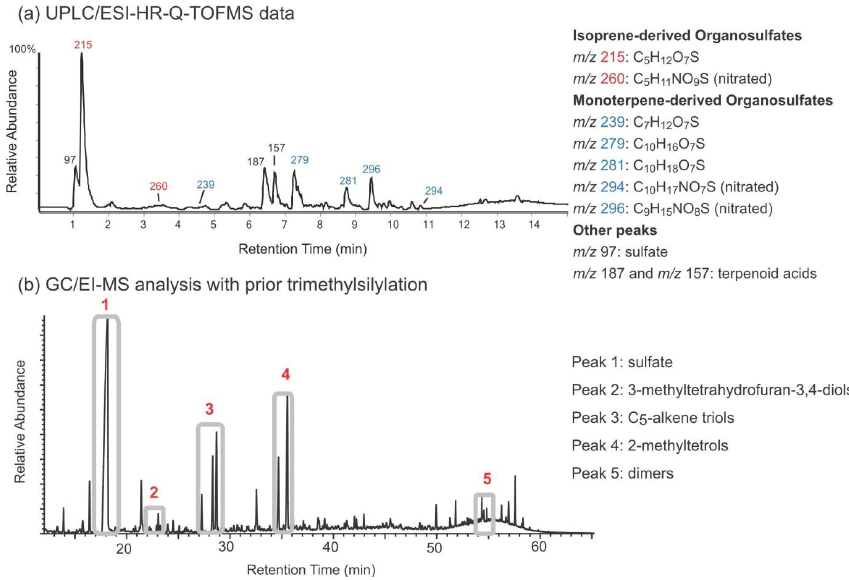
Fig. 2. Representative (a) UPLC/ESI-HR-Q-TOFMS base peak chromatogram and (b) GC/EI-MS total ion chromatogram of the PM 2 . 5 sample collected at YRK on 27 June 2010 under high-SO 2 conditions, showing isoprene-derived SOA tracers were major SOA constituents detected at this site during summertime.